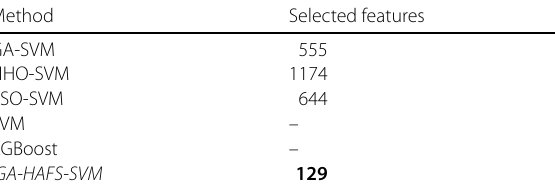
Table 4 Performance of test set on four